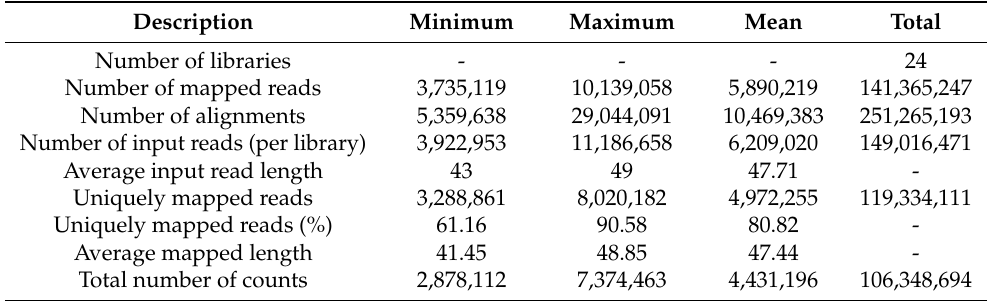
Table 1. Quality-control statistics from an analysis of RNA sequencing raw read